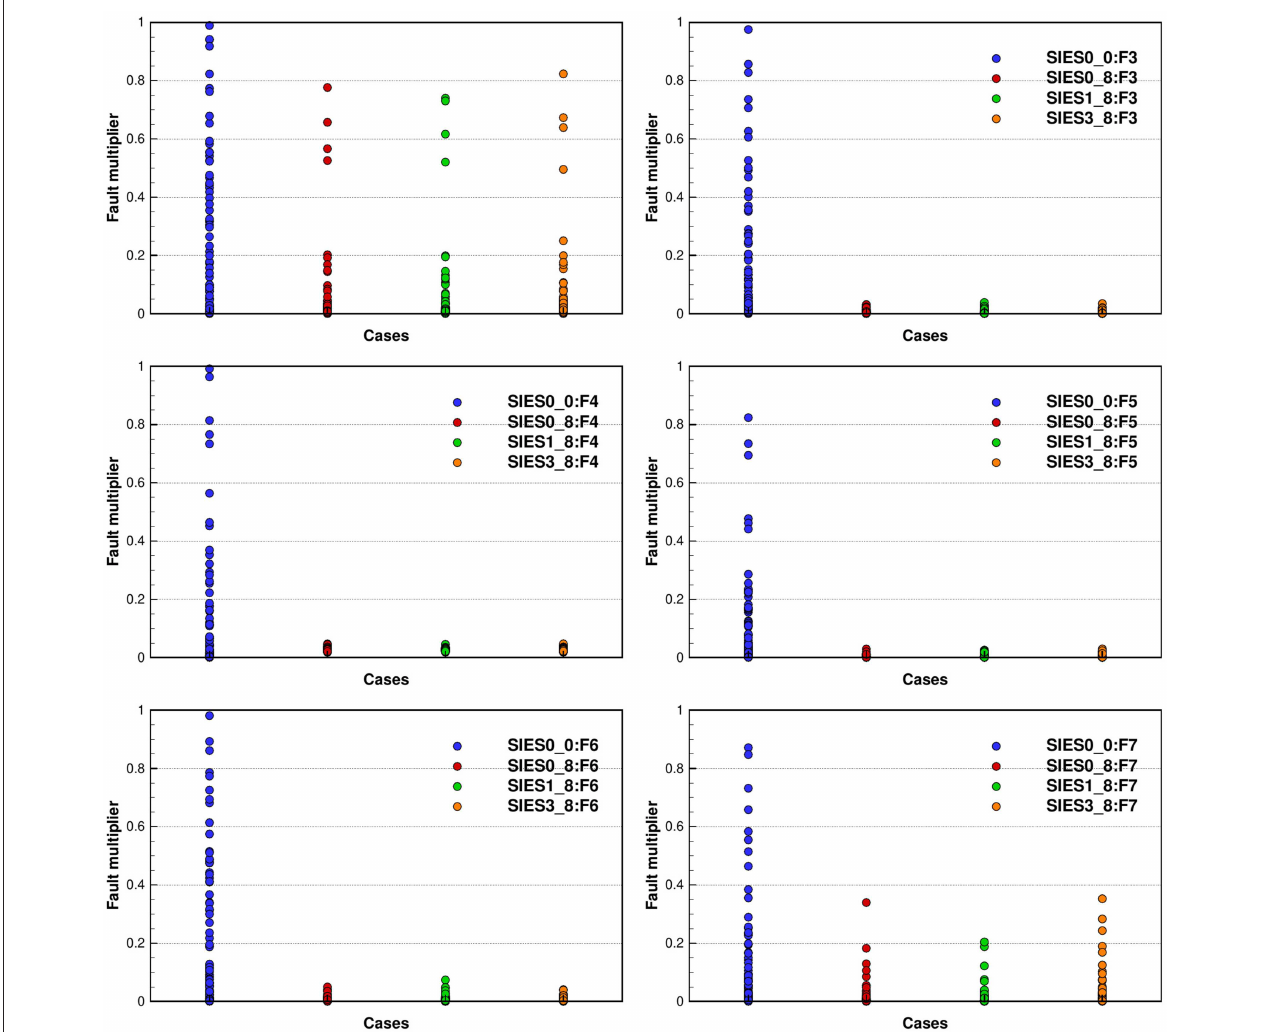
FIGURE 7 | Reservoir case: the plots show the initial and estimated fault multipliers (after 8 iterations) for the six faults F2–F7, using the three different inversion schemes (for the plot of F2, we conveniently removed the figure legend). These plots show consistency between the different inversion schemes. The results are slightly different but qualitatively the same. See section 5.3 for explanation of the three different inversion schemes used.